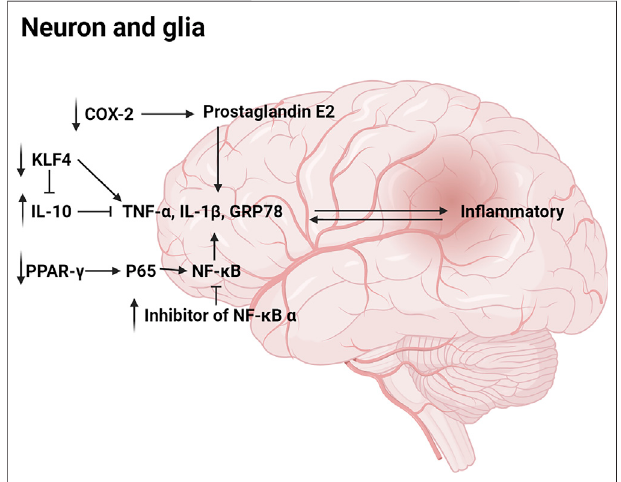
FIGURE 5 | Mechanisms involved in the anti-in fl ammatory by